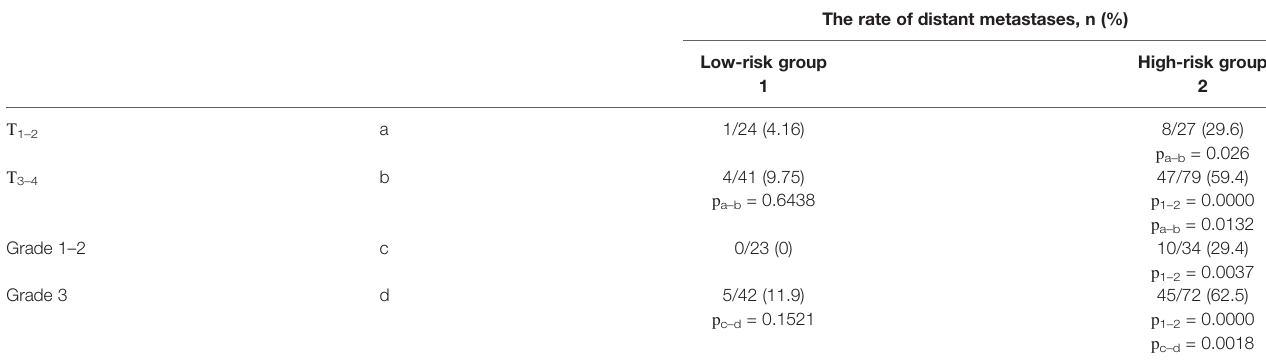
TABLE 3 | The frequency of distant metastases depending on the cancer stage and the grade, separately for the low- and high-risk in NSCLC patients.